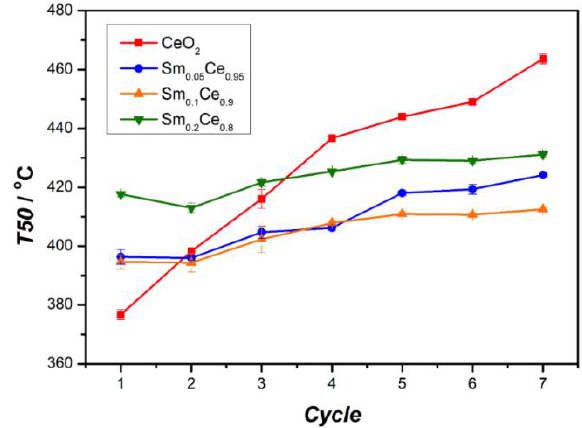
Figure 8. Stability of Sm-doped CeO 2 for soot oxidation.